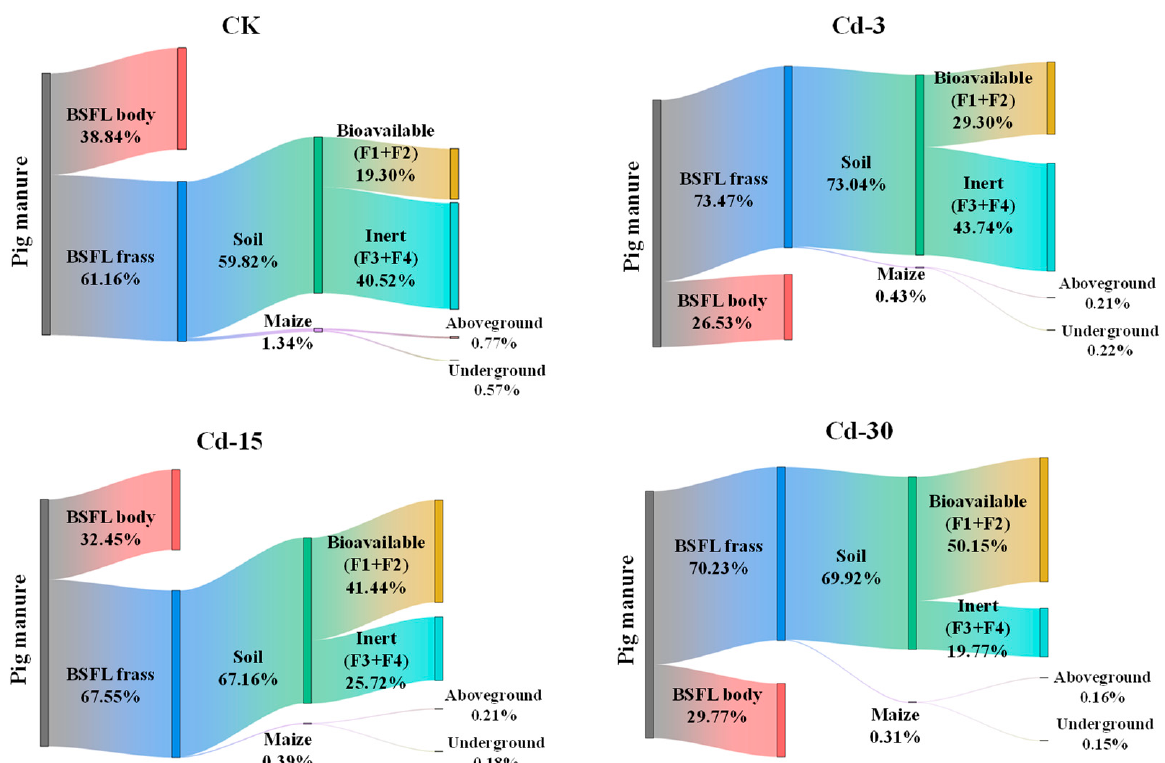
Figure 4. Migration and distribution of Cd in pig manure–BSFL frass–soil–maize system under different treatments.